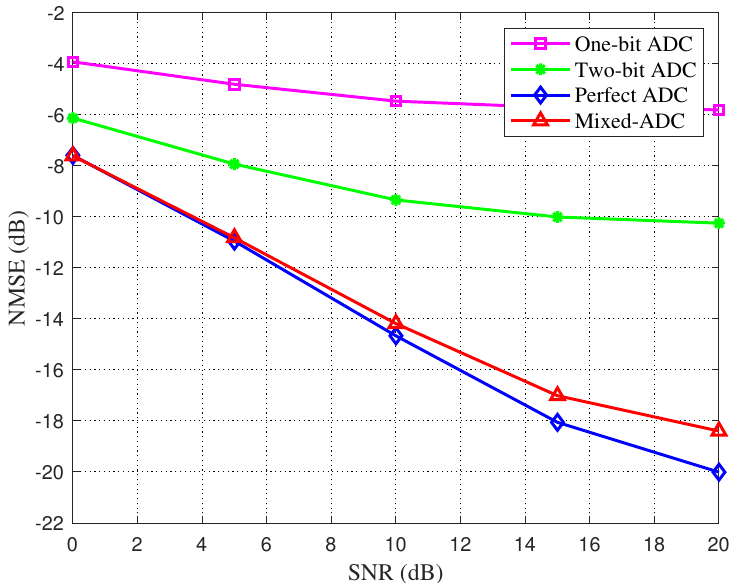
Figure 4. Channel estimation error is a function of SNR. Variations of estimation errors in different resolution ADCs quantification in LAMP network schemes are plotted.